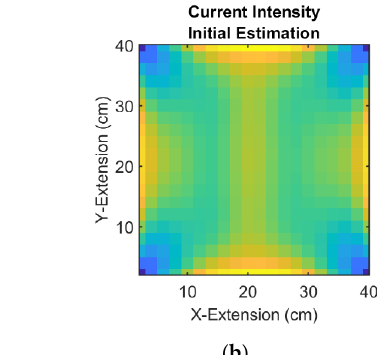
Figure 7. Reconstruction of the differential magnetic dipoles and resulting eddy currents from dif- ferential measurement of an inhomogeneous 2D object: ( a ) “unknown” object. Green background 0,5 S/m, higher conductivity 1 S/m in yellow, lower conductivity 0,25 S/m in blue; ( b ) show the reconstruction of the differential magnetic dipole moments using the differential signals in position Phi; ( c ) the differential magnetic dipole moments in position Psi; ( d ) Reconstruction of the differen- tial eddy current in position Phi from moments; ( e ) Differential eddy current in position Psi. ( f ) Calculated total eddy current in position Phi from the differential eddy current in position Phi and the estimated eddy current in position Phi; ( g ) Total eddy current in position Psi. performed. The input variables are fields of the actually measured (Figure 7f,g and the resulting Figure 8a) and estimated current intensities (21) (Figure 2b,c, resulting to Figure 8b), which serve as corrections (22) for the estimated conductivity distribution.